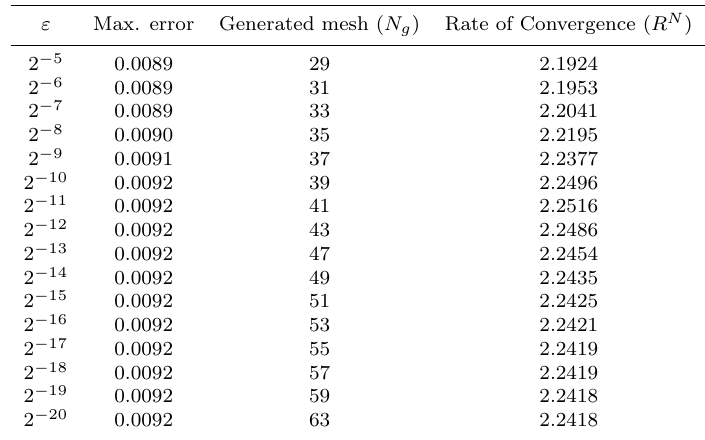
Maximum absolute error for Example 1 for different values of ε with N = 23 (initially) ε Max. error Generated mesh ( N g ) Rate of Convergence ( R N ) 2 −